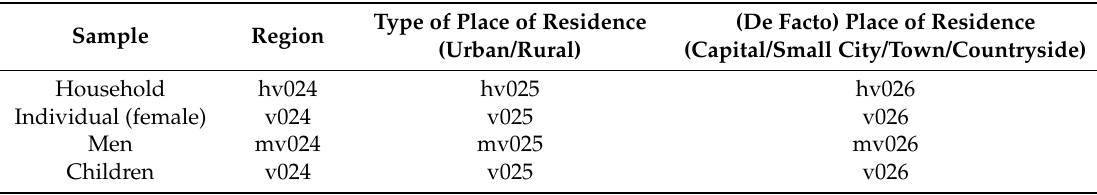
Table A1. Variable codes in the DHS used to identify the urban sample from a capital city in each sample